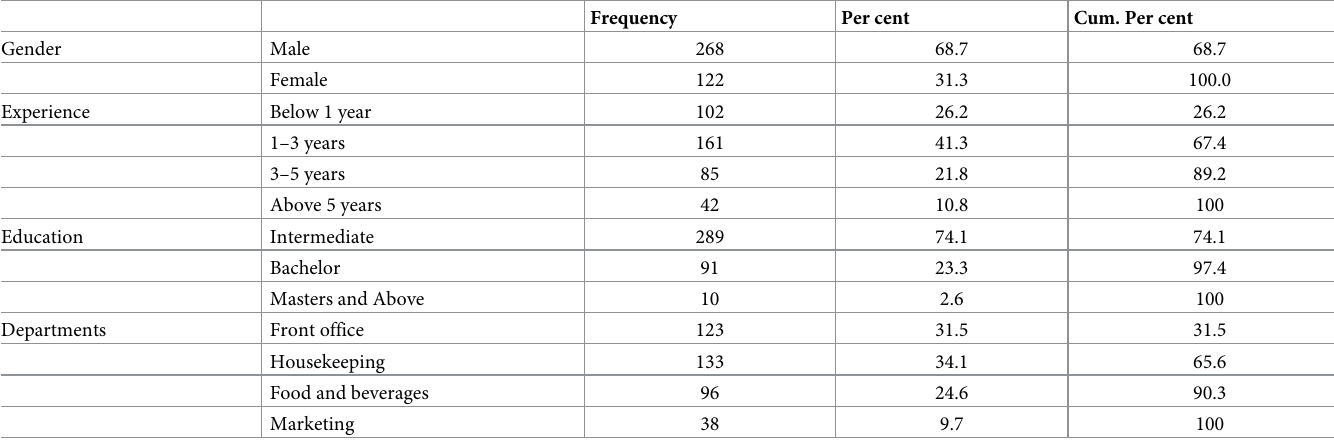
Table 1. Demographics of the respondents (N =